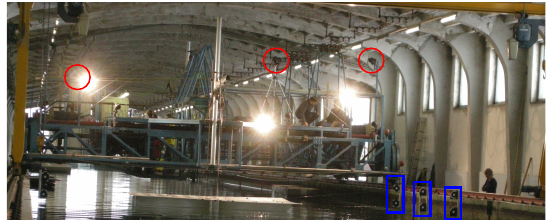
Figure 10. Red circles point to three cameras placed on a moving platform, across the model basin. The blue rectangles point to three scale bars. The remaining scale bars are symmetrically arranged on the opposite side of the basin.